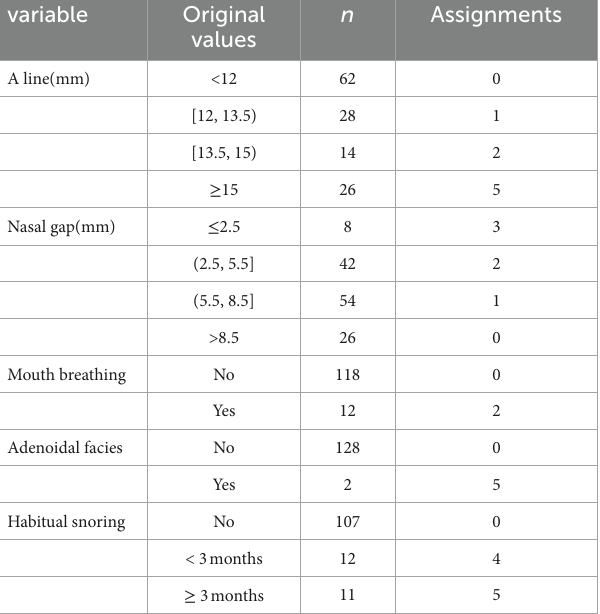
TABLE 3 Assignments for clinical